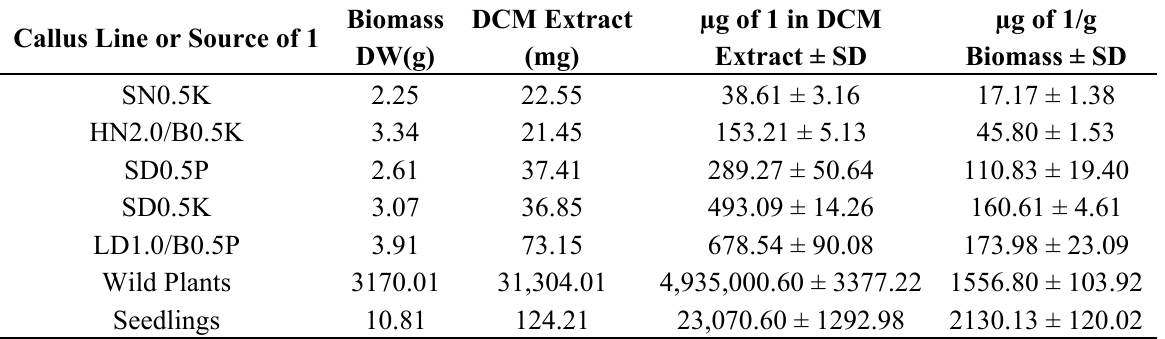
Table 3. Quantify of compound 1 , in callus selected lines, wild plants and seedlings of Lopezia racemosa Cav